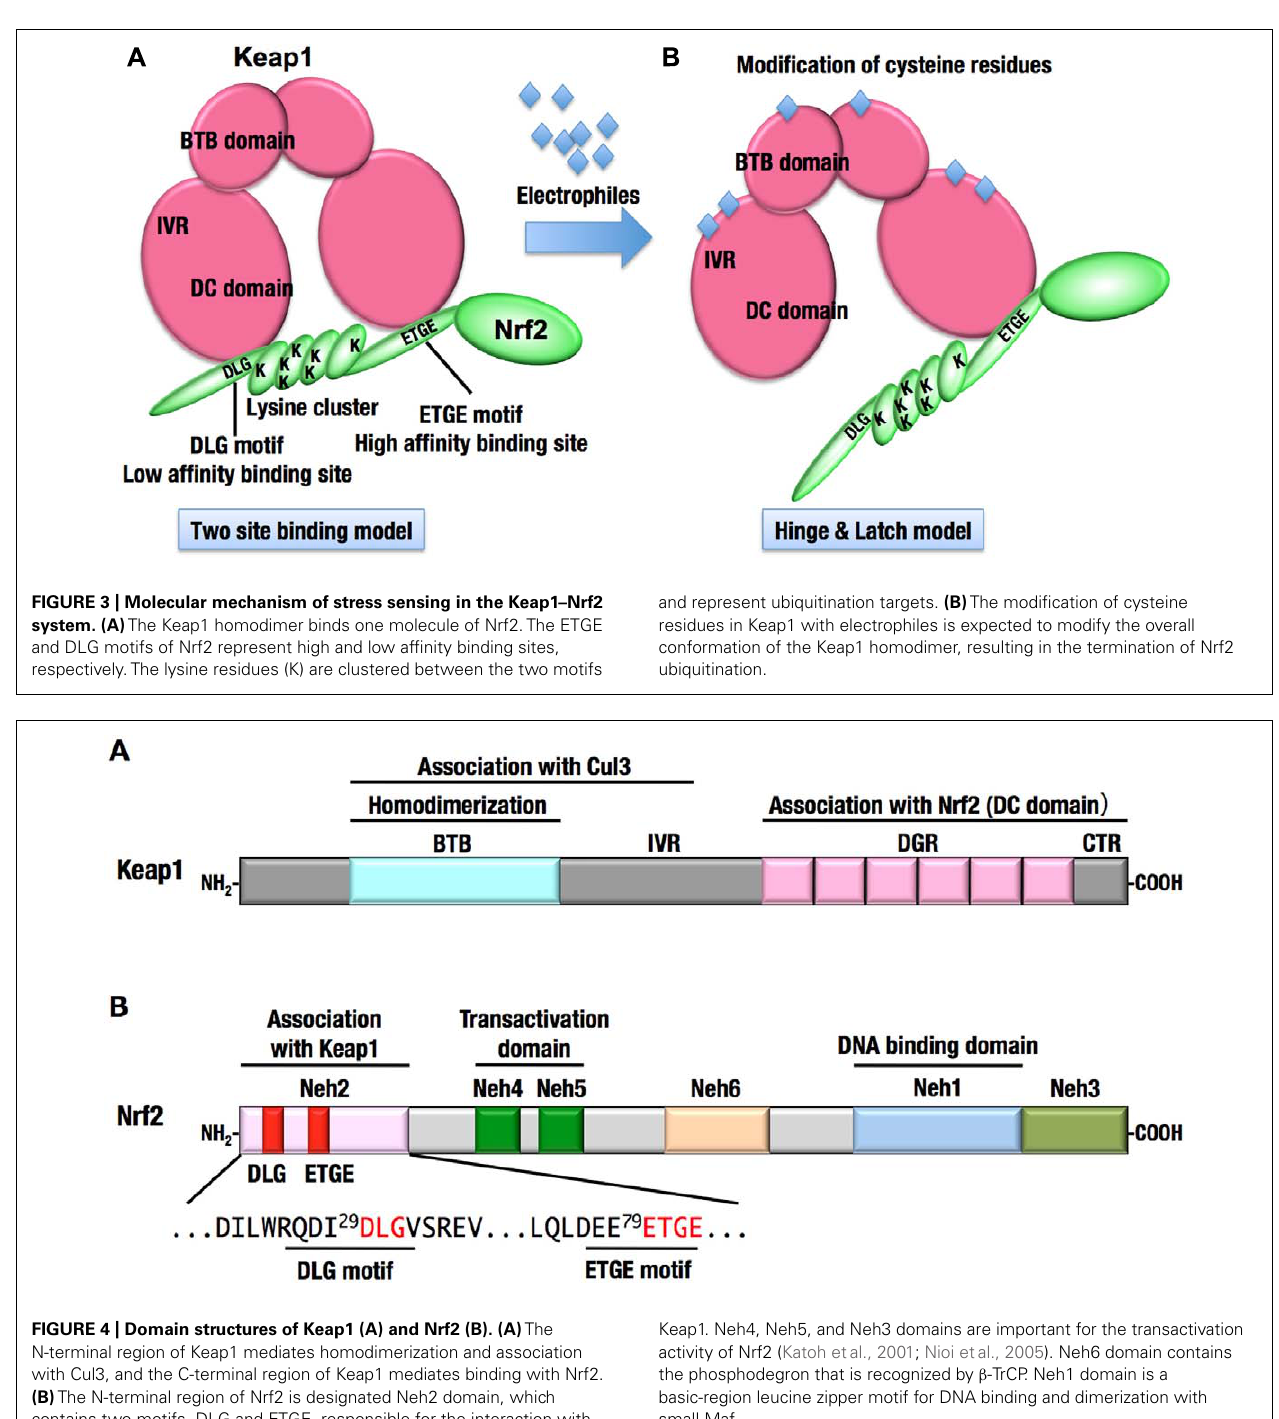
Keap1. Neh4, Neh5, and Neh3 domains are important for the transactivation activity of Nrf2 (Katoh etal., 2001; Nioi etal., 2005). Neh6 domain contains the phosphodegron that is recognized by β -TrCP. Neh1 domain is a basic-region leucine zipper motif for DNA binding and dimerization with small